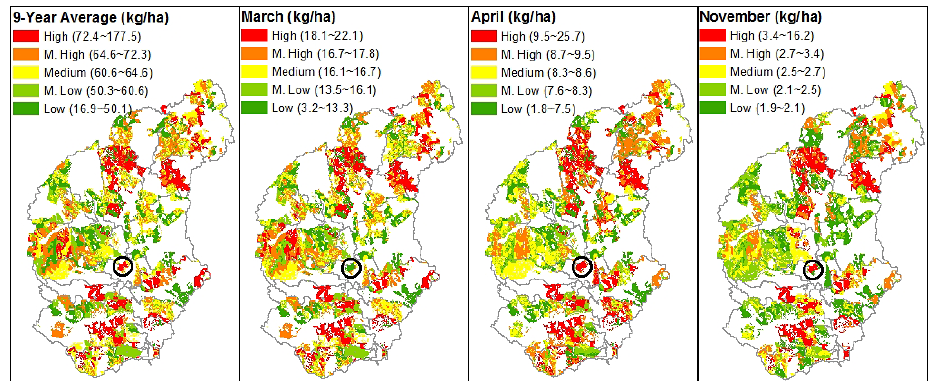
Figure 9. The spatial distribution of nitrate export potential from agricultural fields. Note: Nitrate export potential was computed by adding the annual or monthly averaged amount of nitrate leaching to the groundwater (L) and leaving to the streams by surface runoff, lateral flow, and groundwater (DPs) from the 9-year simulation results. Estimated nitrate loads from the HRUs were classified into five groups. In the legend M. High refers to Moderately High and M. Low Moderately Low. The HRUs within the black circle indicates outliers with extremely high nitrate loadings. This area is characterized by poorly drained hydric soil (“Urban land”) and consistently produces extremely high nitrate loadings throughout years and seasons. The white area is non-agricultural land as shown in Fig.